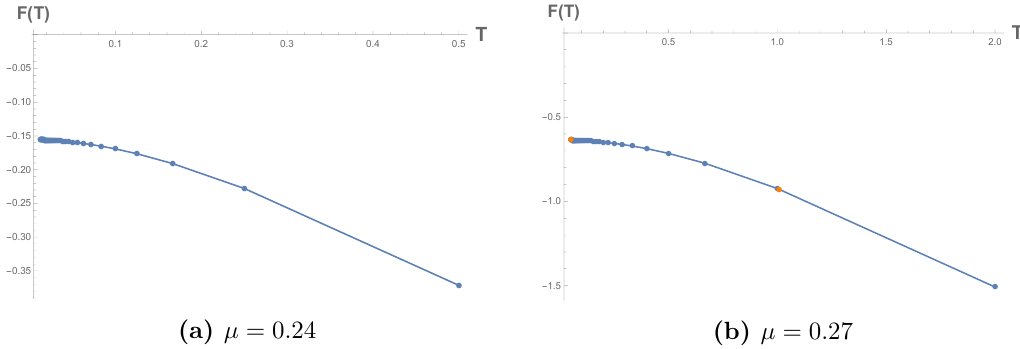
Figure 3. Plot of free energy F with varying temperature T for di(cid:11)erent values J 2 and J 4 = 1. No phase transition is observed. (a) J 2 = 0 : 5 and cooling down in inverse temperature steps of (cid:1) (cid:12) = 2 upto (cid:12) = 80. (b) J 2 = 2 and the blue curve is for inverse temperature steps of (cid:1) (cid:12) = 0 : 5 and cooling down upto (cid:12) = 20. The orange dots are for cooling down with a big inverse temperature step from (cid:12) = 1 to (cid:12) =